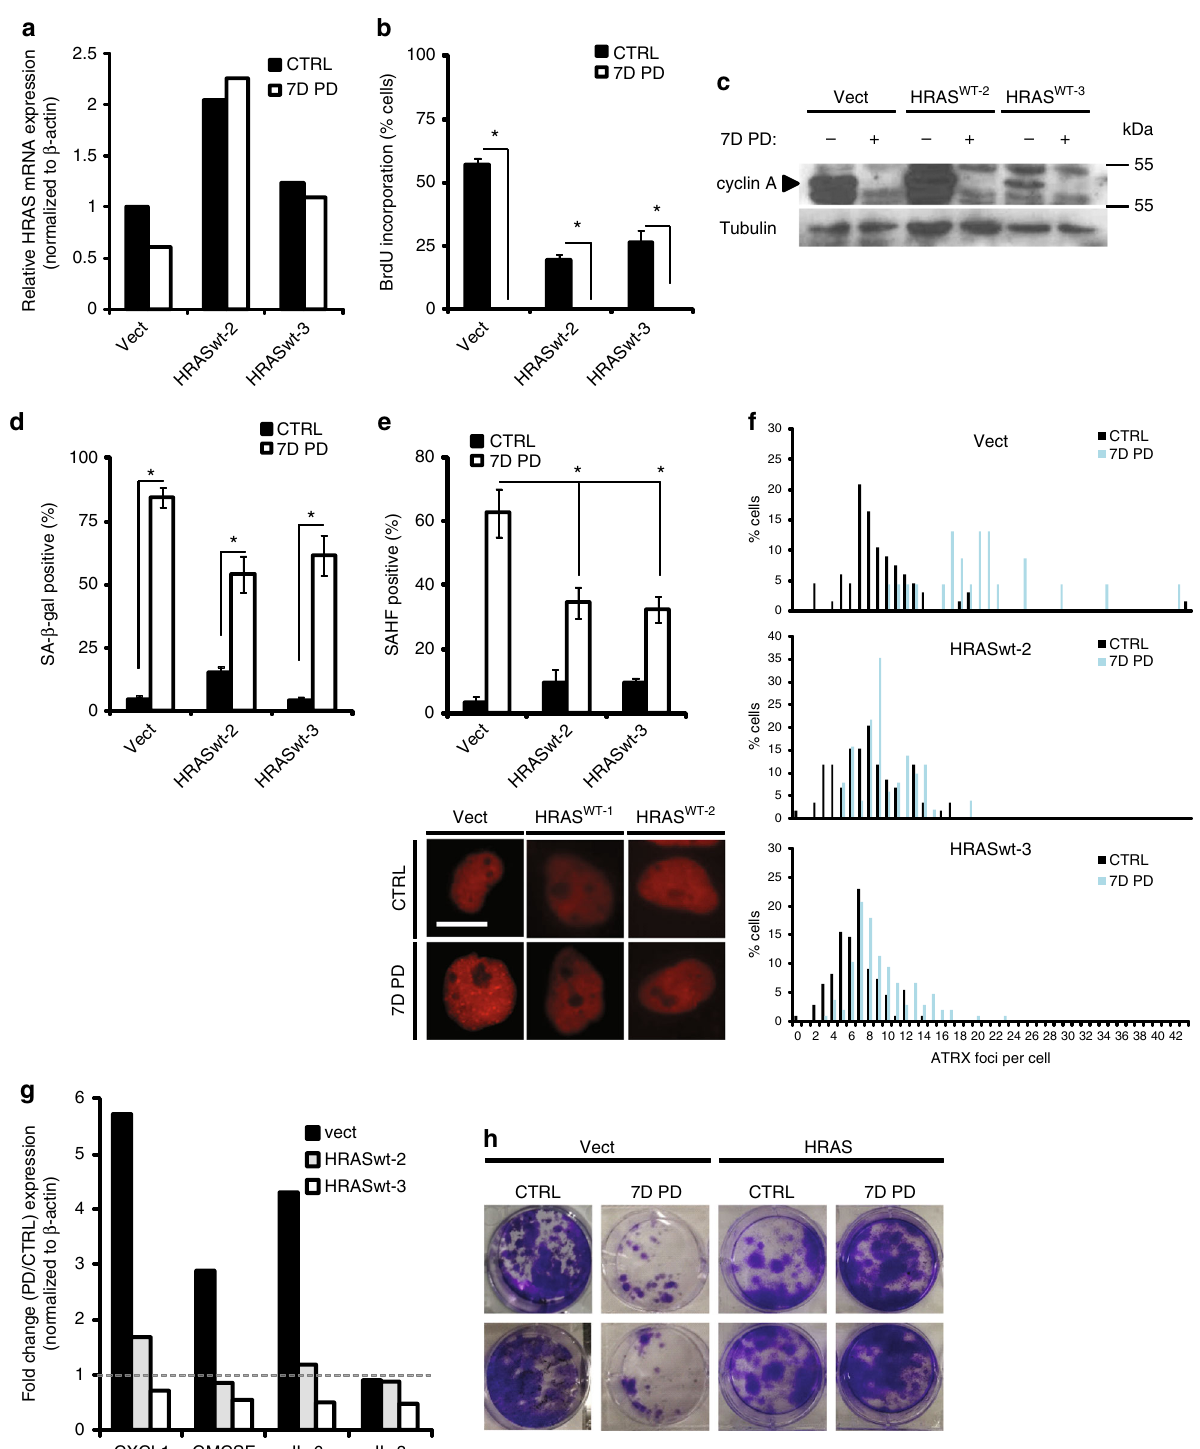
Fig. 7 Stabilizing HRAS expression prevents the transition from quiescence to senescence. a – h Wild-type HRAS (HRASwt) or a vector control (vect) was stably expressed in LS8817. After 4 days of selection with puromycin, cells were treated with 1 μ M of PD0332991 for seven additional days (7D PD) and compared to cycling (CTRL) cells and analyzed for the following: HRAS mRNA levels measured by qPCR ( a ), growth arrest by BrdU incorporation ( b ) and cyclin A immunoblot ( c ), SA- β -gal ( d ), HP1 γ SAHF ( e ), number of ATRX foci on an individual basis ( f ), induction of four SASP factors as measured by qPCR ( g ), and ability to return to cell cycle once PD0332991 once the dug was removed ( h ). Representative SAHF images are shown below panel e. Colony formation in panel h was not quanti fi ed as individual colonies could not be distinguished. Individual experiments are presented and all data are represented as mean ± SEM from three independent fi elds of view. Asrterisk indicates p < 0.05 using a two-sided Student ’ s t- test. All images were taken at the same magni fi cation. The scale bar is 20 microns. See also Supplementary Fig. 10 for uncropped